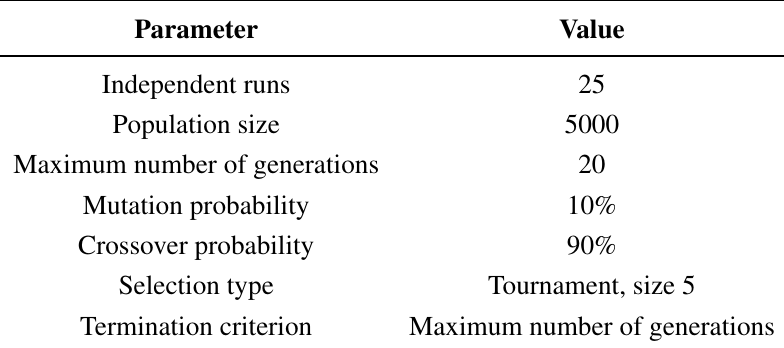
Table 1. Parameter settings for the GA